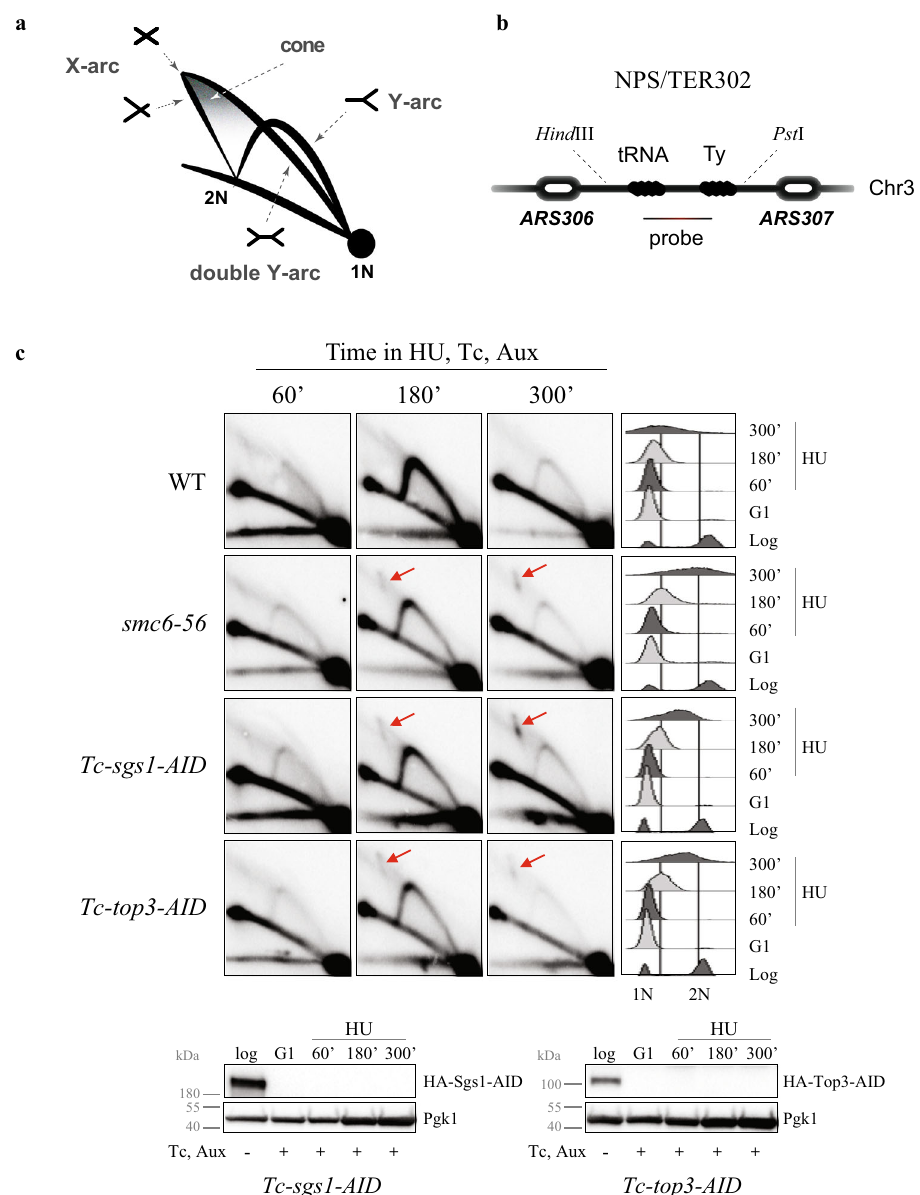
Fig. 2 STR and Smc5/6 prevent joint molecule accumulation at stalled replication forks and termination regions. a Schematic representation of replication intermediates arising at termination regions as observed by 2D gel electrophoresis. The migration pattern of different replication intermediates referred to in the text is illustrated. b Schematic representation of the NPS302/TER302 region analysed by 2D gel electrophoresis. c Visualization of replication intermediates by 2D gel electrophoresis from cells of the indicated genotype synchronously released from G1 in media containing 200 mM HU, as well as Auxin (Aux) and Tetracycline (Tc). FACS pro fi les indicated on the right show cell cycle progression. Sgs1 and Top3 tagged with HA were depleted with Auxin and Tetracycline as indicated by Western blots. Pgk1 was used as loading control. Joint molecules accumulating on the X-arc are indicated by red arrows. The experiment was performed reproducibly twice. See also Supplementary Figs. 3 and 4. Source data are provided as a Source Data fi